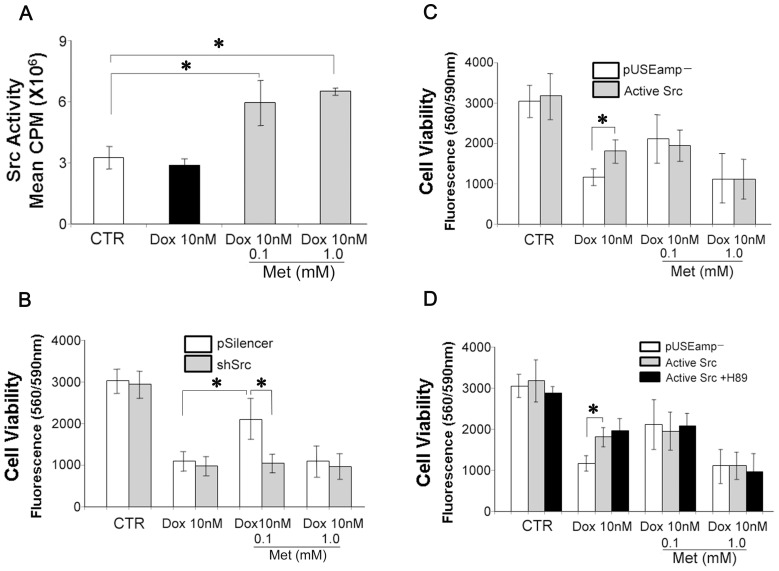
Protective effect of Met against Dox induced cytotoxicity is mediated by PKA dependent Src activation.(A) H9c2 cardiomyoblasts were cultured with reduced FBS (1%) for 72 hours, with indicated conditions. Src kinase activity was determined as described in Materials and Methods. The histograms show the average Src activity in CPM. (B) H9c2 cells stably transfected with short hairpin RNAi against cSrc (shSrc) or scrambled oligo encoded control plasmid (pSilencer) were cultured for 72 hours with reduced FBS (1%) the indicated conditions. The cell viabilities were evaluated as described. (C) H9c2 cells stably transfected with a constitutively active Src or a control empty vector (pUSEamp-) were cultured for 72 hours with reduced FBS (1%) under the indicated conditions. The cell viabilities were evaluated as described. (D) H9c2 cells stably transfected with an active Src or a control plasmid (pUSEamp-) were cultured for 72 hours under the indicated conditions with or without H89 (10 µM). Values represent mean ± S.D. (n = 4) from quadruplicate samples for each treatment at varying treatment conditions. *, Statistically significant (p<0.05).